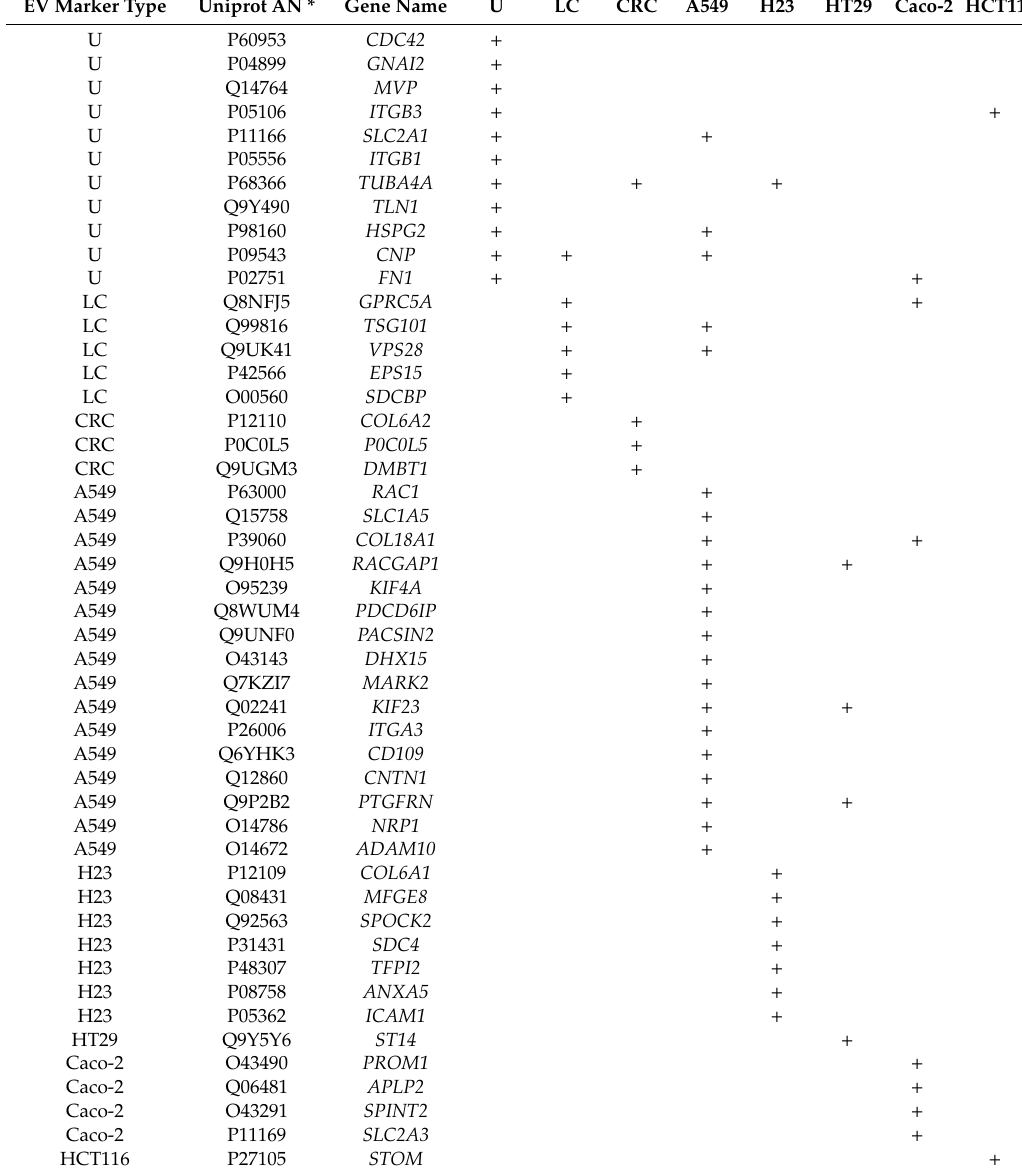
Table 1. Summary table for universal, tissue-specific, and line specific EV